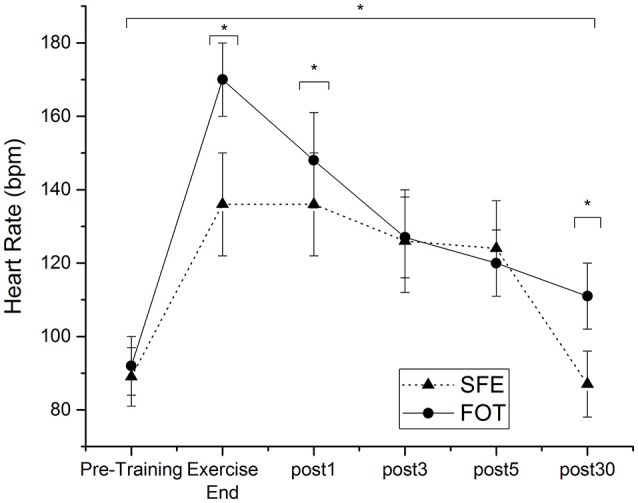
Heart rate (HR) at the end of the exercise and HR recovery 1, 3, 5, and 30 min after SFE and FOT. *Significant difference between heart rate recovery of SFE and FOT (P < 0.05).